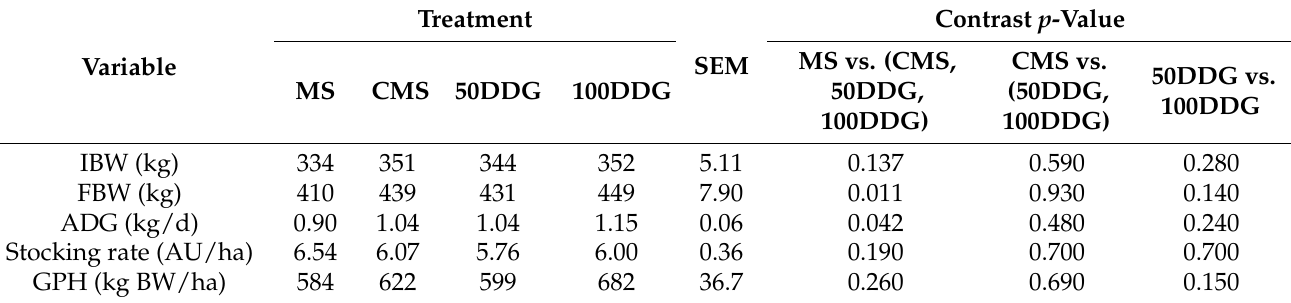
Table 7. Performance, stocking rate, and gain per area of Nellore young bulls fed with mineral supplementation (MS); conventional multiple supplement (energy/protein) with cottonseed meal and citrus pulp (CMS); supplement with 50% of CMS protein source replaced by DDG (50DDG); and supplement with 100% of CMS protein source replaced by DDG (100DDG), grazing Marandu grass during the wet season.